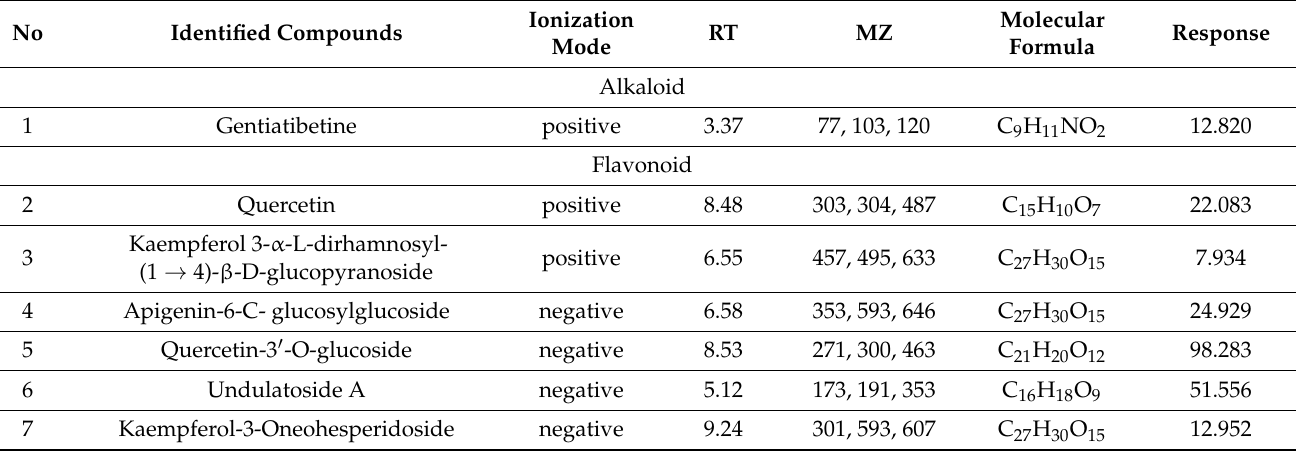
Table 1. LC-MS phytochemical analysis.